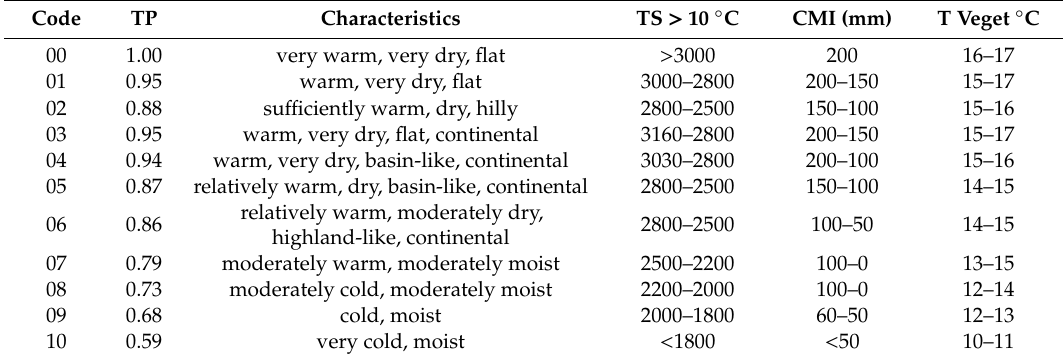
Table 1. Chosen parameters of soil and climatic regions in Slovakia.